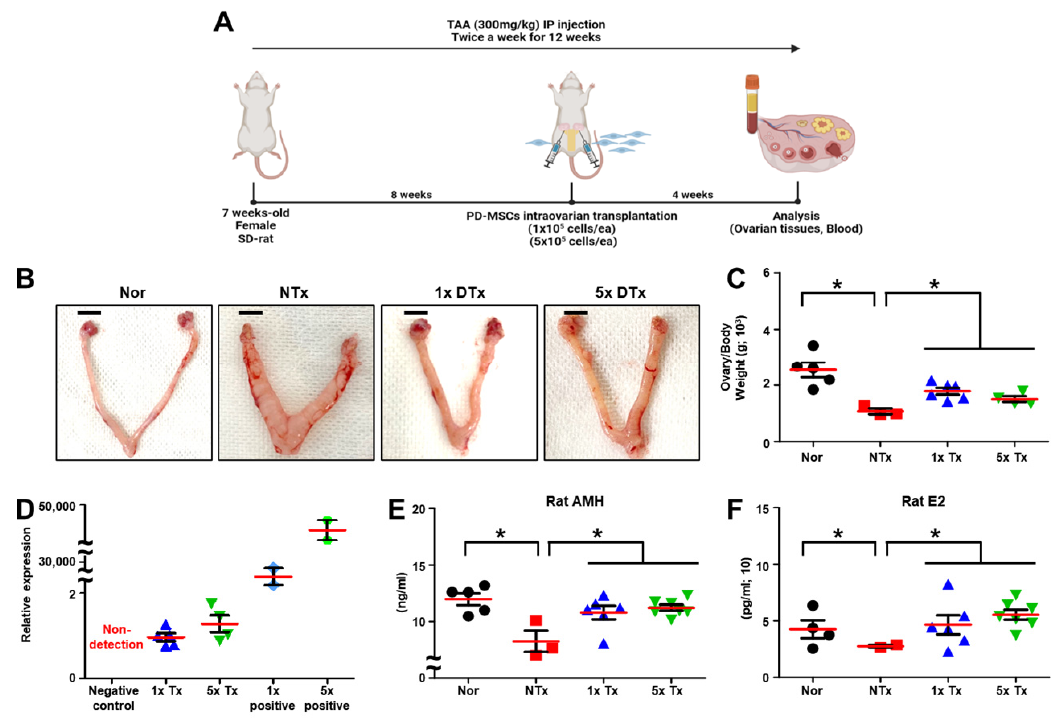
Figure 1. Effect of a low dose of PD ‐ MSCs on ovarian function in rats with ovarian dysfunction. ( A ) Scheme of TAA ‐ injured rat model construction. ( B ) Morphological analysis in ovarian tissues of TAA ‐ injured rats after sacrifice. ( C ) The ratio of ovary weight to body weight was analyzed after sacrifice. ( D ) The mRNA expression of hAlu was analyzed by qRT ‐ PCR. ( E ) The concentrations of AMH and ( F ) E2 in individual serum samples were analyzed by ELISA. The data are representative of three independent experiments and expressed as the mean ± S.D. Statistical significance was determined by using one-way ANOVA, * p <